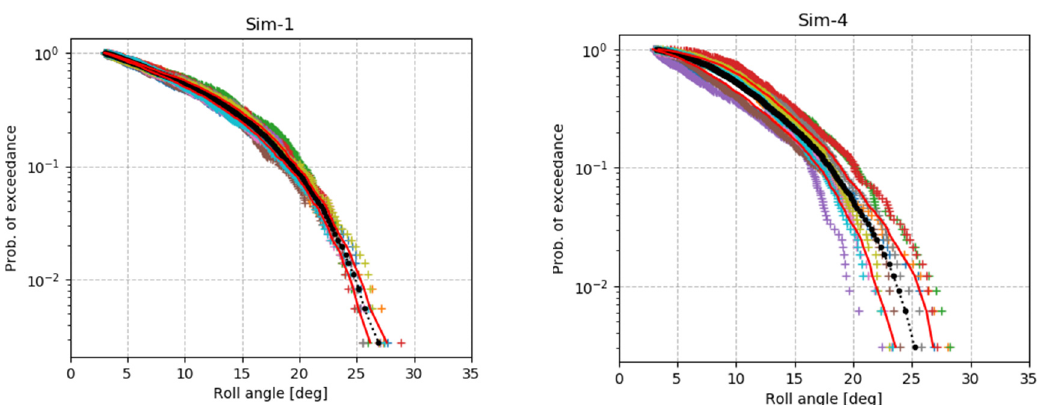
Figure 4. Extreme value distributions of the roll motions from programs Sim-1 (left) and Sim-4 (right) for 10 realisations of the wave. Simulations were run in head seas with Hs = 7 m, Tp = 13.5 s and average speed Vs = 7.9 kn.